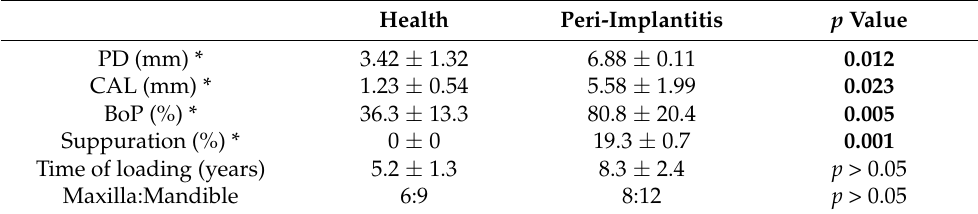
Table 2. Mean ± SD of the periodontal parameters and clinical characteristics of evaluated implant supported restoration from control (healthy, n = 15 subjects) and test (diseased, n = 20 subjects) groups. Mann–Whitney U test (* p < 0.05); ns: no significant. Health